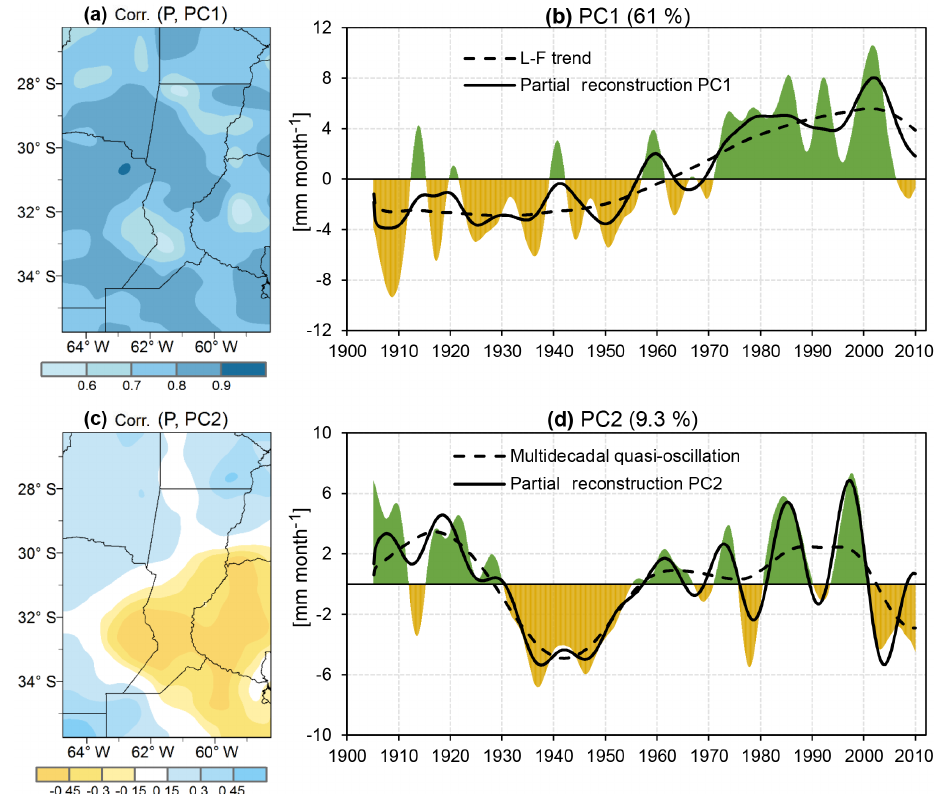
Figure 6. First two leading patterns of decadal-to-multidecadal precipitation variability characterized by the 120m low-pass-filtered monthly mean precipitation anomalies. Panels (a) and (c) show the spatial distribution of the correlation between PCs (in b and d ) and each precip- itation time series at a single grid point. Percentages of explained variance are given in brackets. Black lines depict the leading modes of variability (dashed) and the partial reconstruction of each PC using all modes described in Table 2 (continuous).